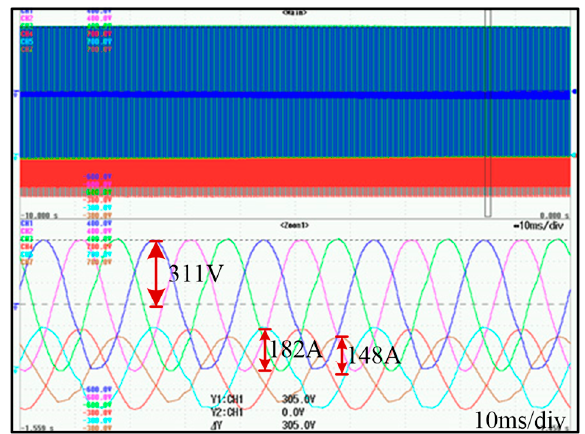
Figure 16. Voltage and current waveforms with unbalanced load.